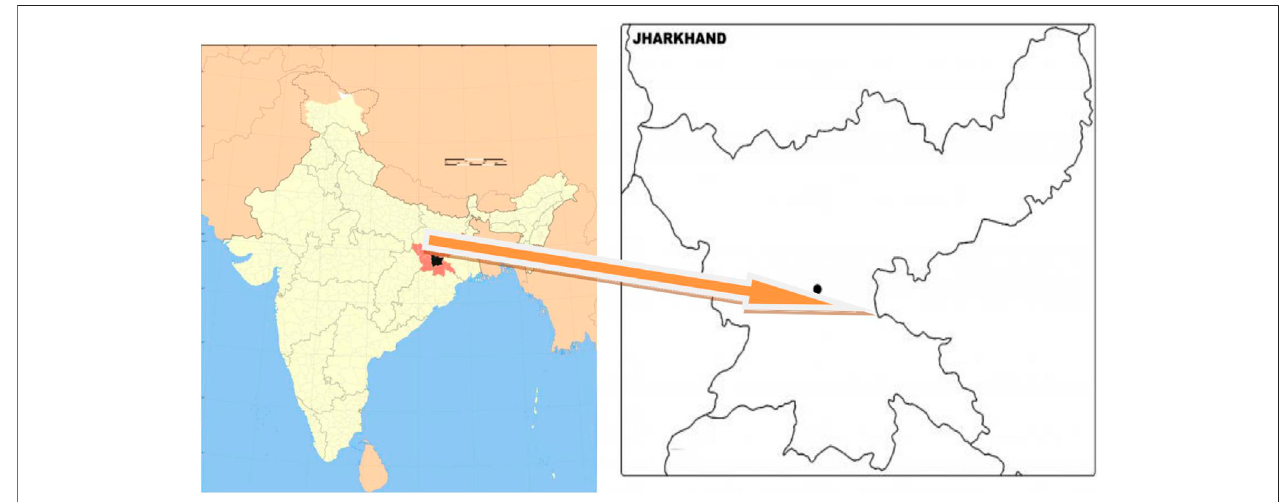
FIGURE 1 | Experimental site under study.